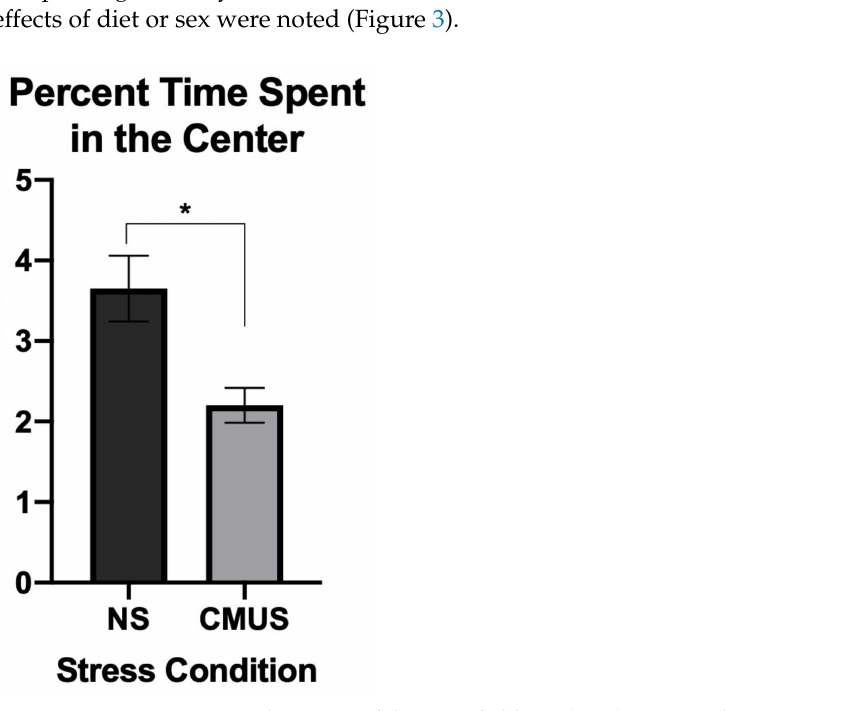
Figure 3. Percent time spent in the center of the open field test (OFT). Mice undergoing CMUS spent significantly less time in the center of the OF compared to NS mice (NS) (* p < 0.05; p =